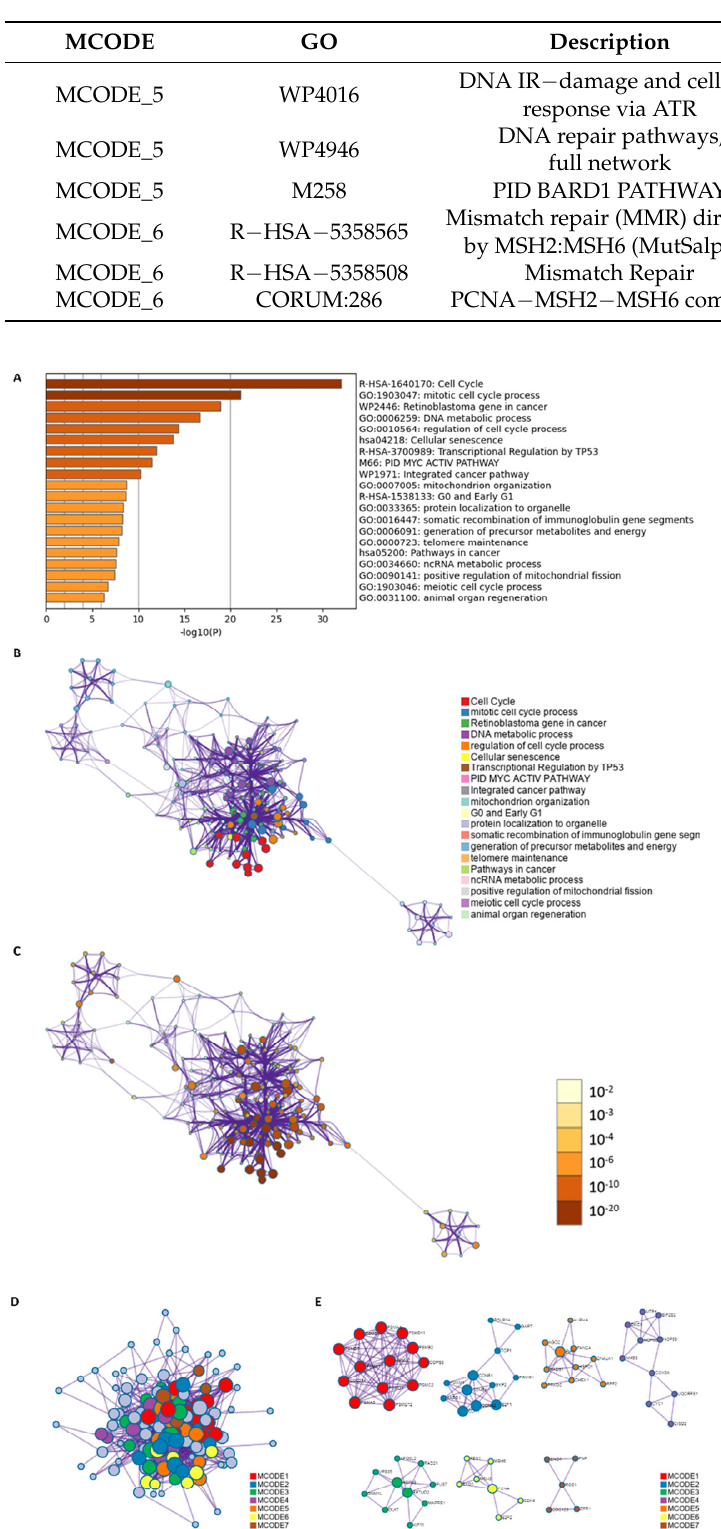
Figure 6. Gene enrichment analysis of the shared genes between genes co-expressed with CISD1 and “diabetes mellitus”. Pathways and functional terms enrichment results ( A ); Relationships of the terms listed by color ( B ); and p -value ( C ). Densely connected MCODE networks ( D ); and detailed MCODE networks ( E ).